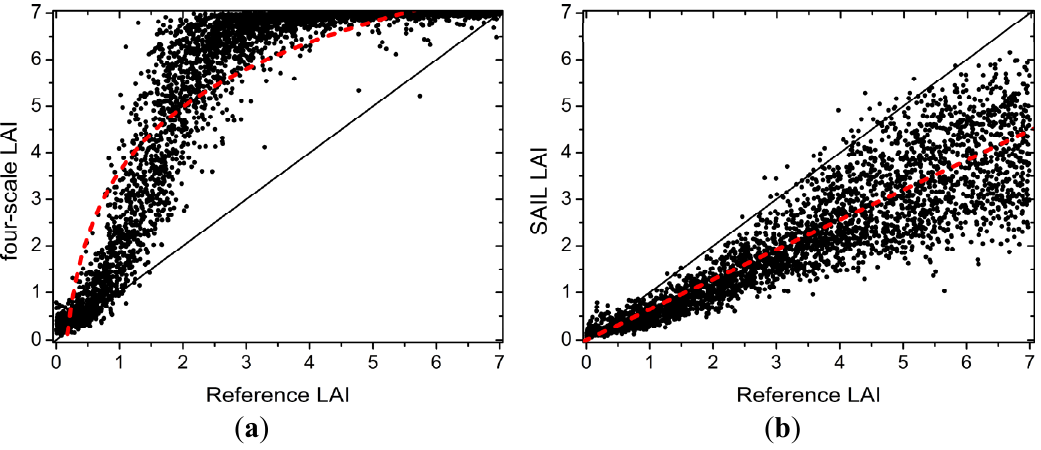
Figure 4. Scatter plots of the estimated and actual values of LAI. Using four-scaleNN to invert the SAIL test dataset ( a ) and using SAILNN to invert the four-scale test dataset ( b ). The dashed lines are the regression lines between the estimated and actual